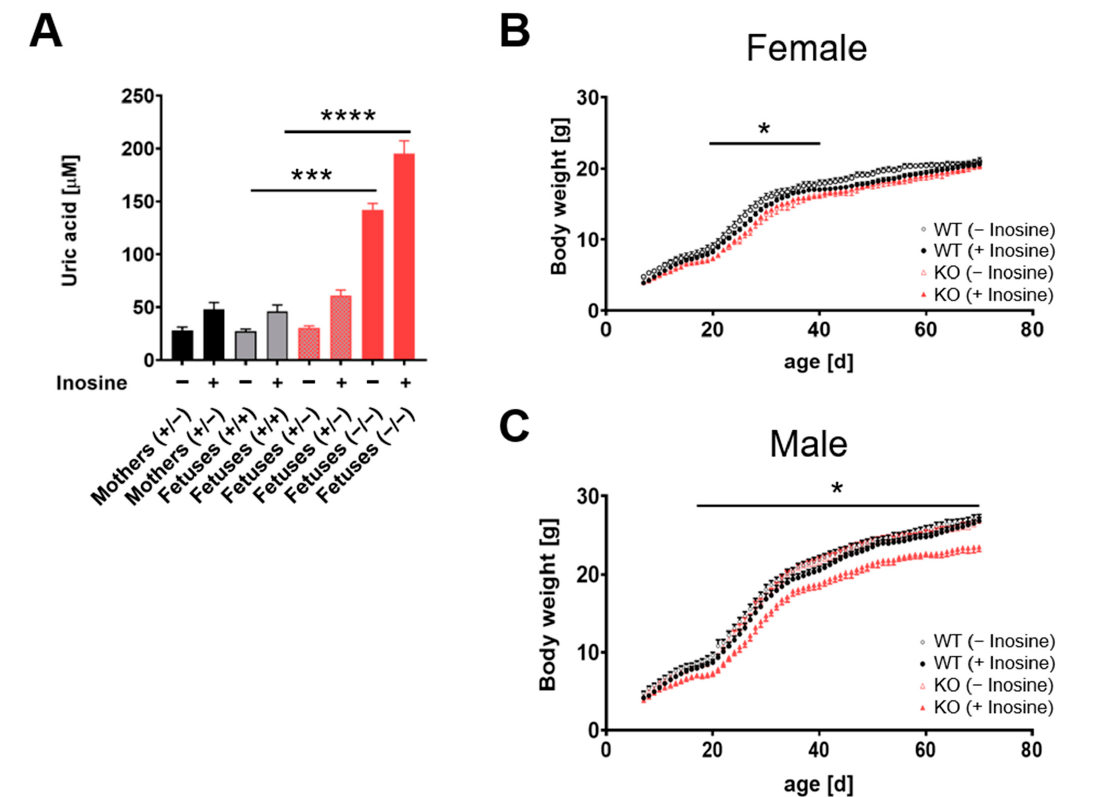
Figure 3. Fetal hyperuricemia and growth pattern: ( A ) Serum uric acid levels at day 18.5 of the pregnant mice fed with standard chow and fetuses of all three genotypes. To increase the KO fetuses’ uric acid levels, the pregnant dams' chow was supplemented with 1 mg/g inosine during the whole gestation. Inosine supplementation further increases the uric acid level of KO animals. ( B , C ) Analysis of weight development of female ( B ) and male ( C ) pups, under control conditions (circles) and inosine supplementation (triangles) during gestation. WT (female n = 7, male n = 7) are shown in black, and KO animals (female n = 5, male n = 8) in red. Data represent mean ± SEM. In female animals ( B ), a statistical significance could be observed during days 19–40 after birth between KO and WT animals without inosine supplementation. No statistical difference could be observed between KO animals with and without inosine. In male animals ( C ), only KO animals exposed to high uric acid concentration during fetal development show a significant difference in body weight from days 18–70 after birth compared to WT controls (+inosine) (female n = 10, male n = 10). No difference could be observed in KO animals (female n = 10, male n = 7) exposed to lower uric acid concentration during fetal development when compared to WT controls ( − inosine). * p < 0.05, *** p < 0.001, **** p < 0.0001. To evaluate the offspring's growth pattern, body weight was measured from postnatal day 7 until day 70, and a histologic examination was performed following sacrifice. While the female KO offspring showed a significantly lower body weight during the accelerated growth period (postnatal day 19 until day 40) compared to the WT peers (Figure